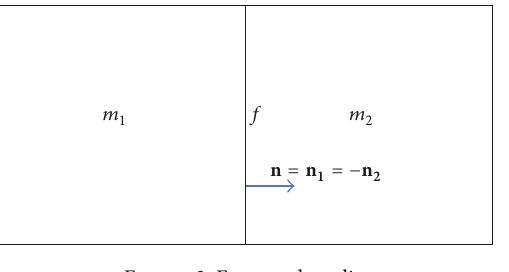
Figure 3: Fractured media.